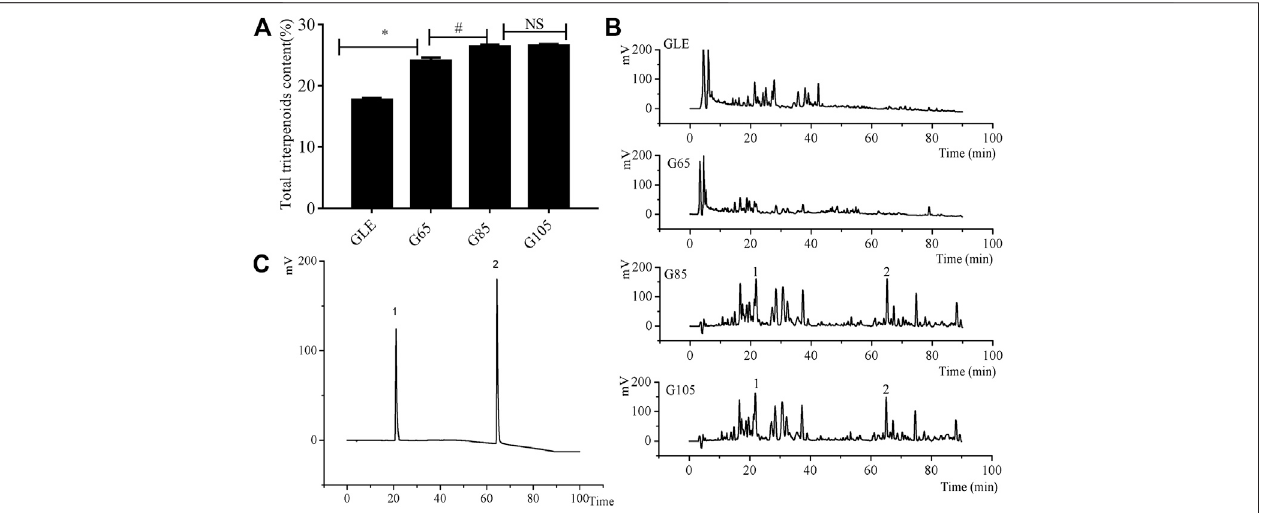
FIGURE 1 | The chemical analysis of the extracts. (A) The total triterpenes content of G. lucidum extracts (B) HPLC chromatograms of G. lucidum extracts (C) HPLC chromatograms ofreference substance. 1) ganoderic acid A, 2) ganodermanontriol. Data were shown as mean ± SD ( n (cid:2) 3), * p < 0.05 vs GLE, # p < 0.05 vs G65, NS means no signi fi cant